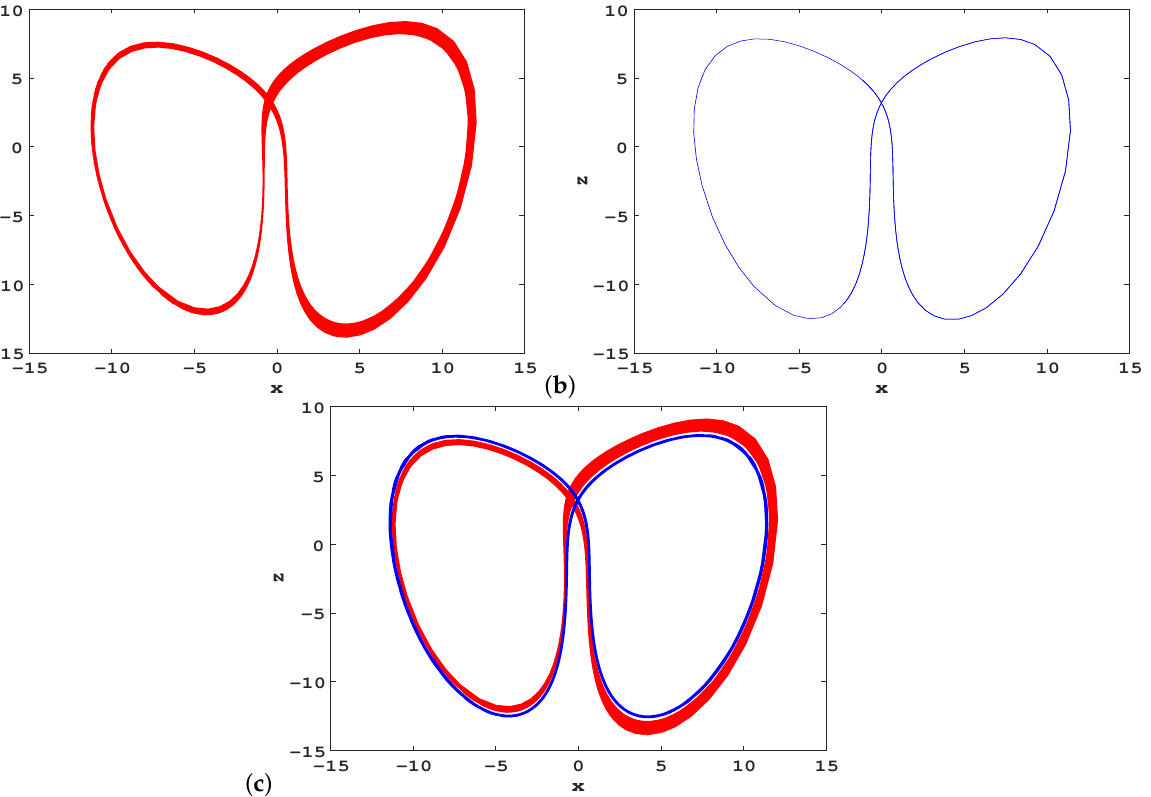
Figure 9. Two coexisting hidden attractors of system (2); ( a , b , c , k , m ) = ( 10,24,2.7, − 0.2,1 ) ; ( a ) quasi- periodic attractor; ( b ) periodic attractor; ( c ) coexisting attractors. The red line represents quasi- periodic attractor and the blue line represents periodic